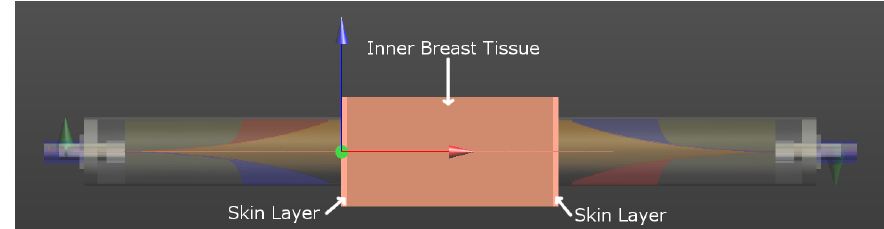
Figure 4. Three-dimensional model used for simulating the transmission system. Two complex Nahanni sensors are present along with a breast model consisting of two 20-mm skin layers and a 56-mm homogeneous interior.